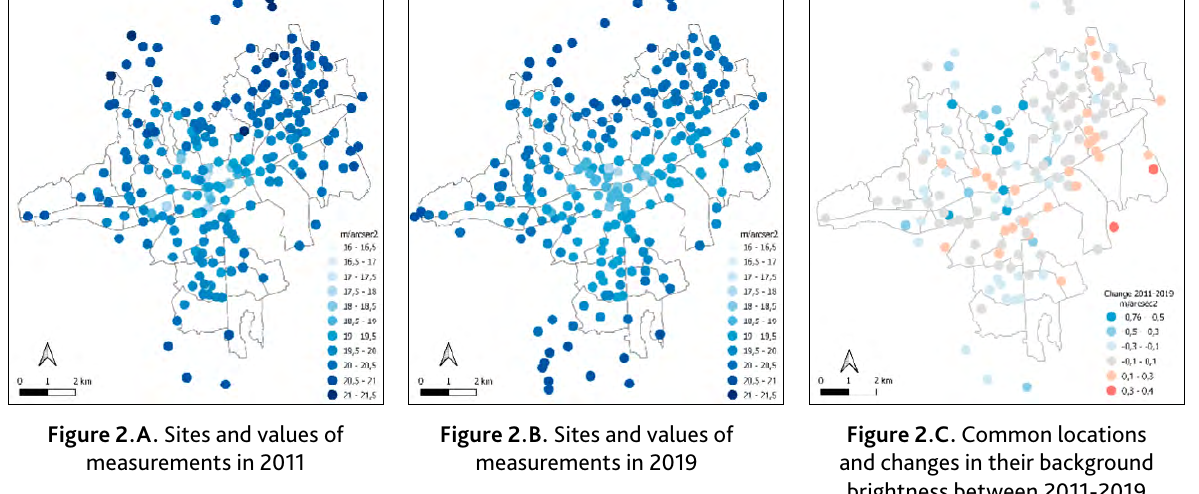
Figure 2.A. Sites and values of Figure 2.B. Sites and values of